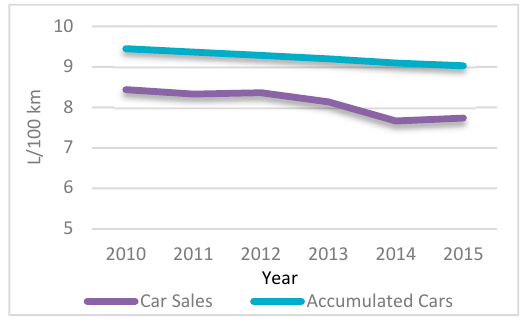
Figure 7. Fuel economy of sold cars and accumulated cars.